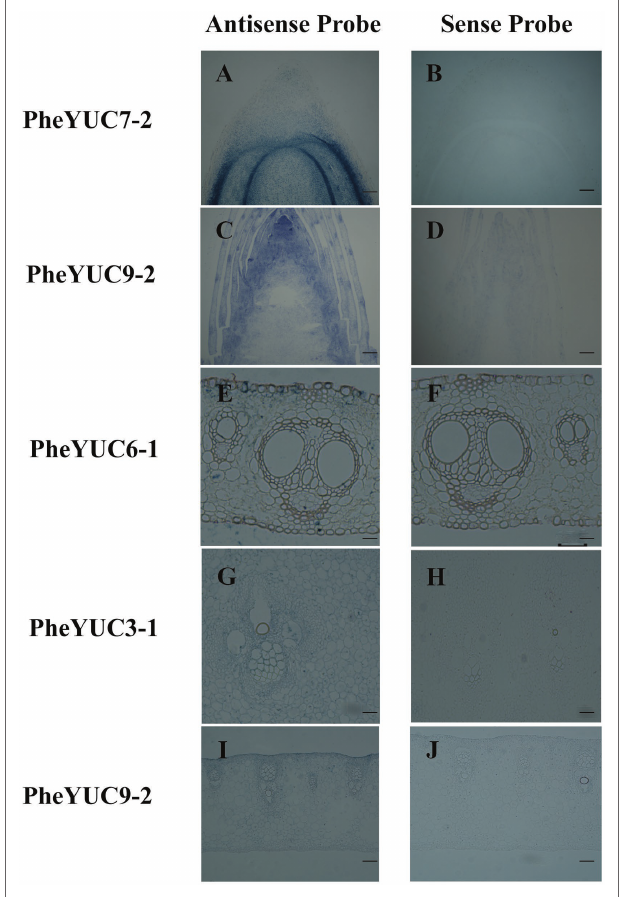
FIGURE 6 | In situ expression analysis of YUCCA genes in different tissues. (A,B) root, (C,D) shoot tip, (E,F) sheath blade, (G,H) bamboo shoot internode 1/5 from the tip, and (I,J) young sheath. Bar = 50 μ